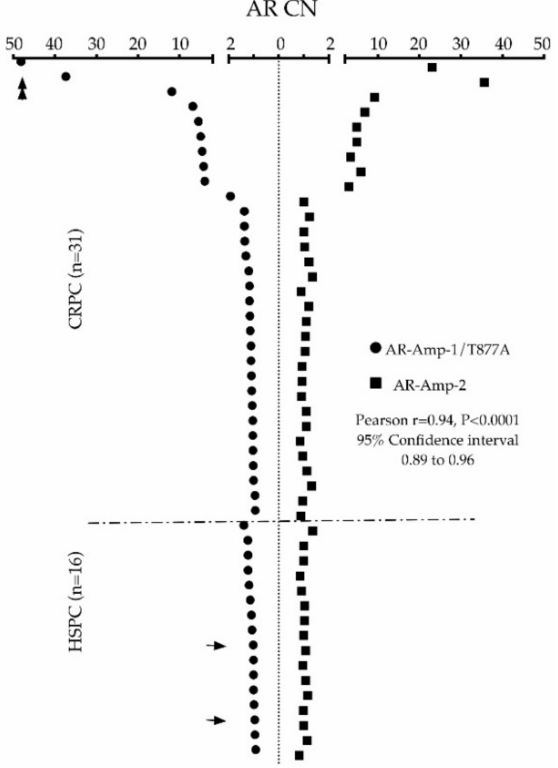
Figure 4. Side-by-side scatter dot plot demonstrating cross-validation of AR CN between AR-Amp- 1/T877A (solid circles) and AR-Amp-2 (solid squares) separated into HSPC vs. CRPC patient groups. Patient sample data are sorted by CN value measured by the AR-Amp-1/T877A method. Arrows indicate patient samples with identified T877A mutation, double arrows indicate patients with large scale Chromosome X CN